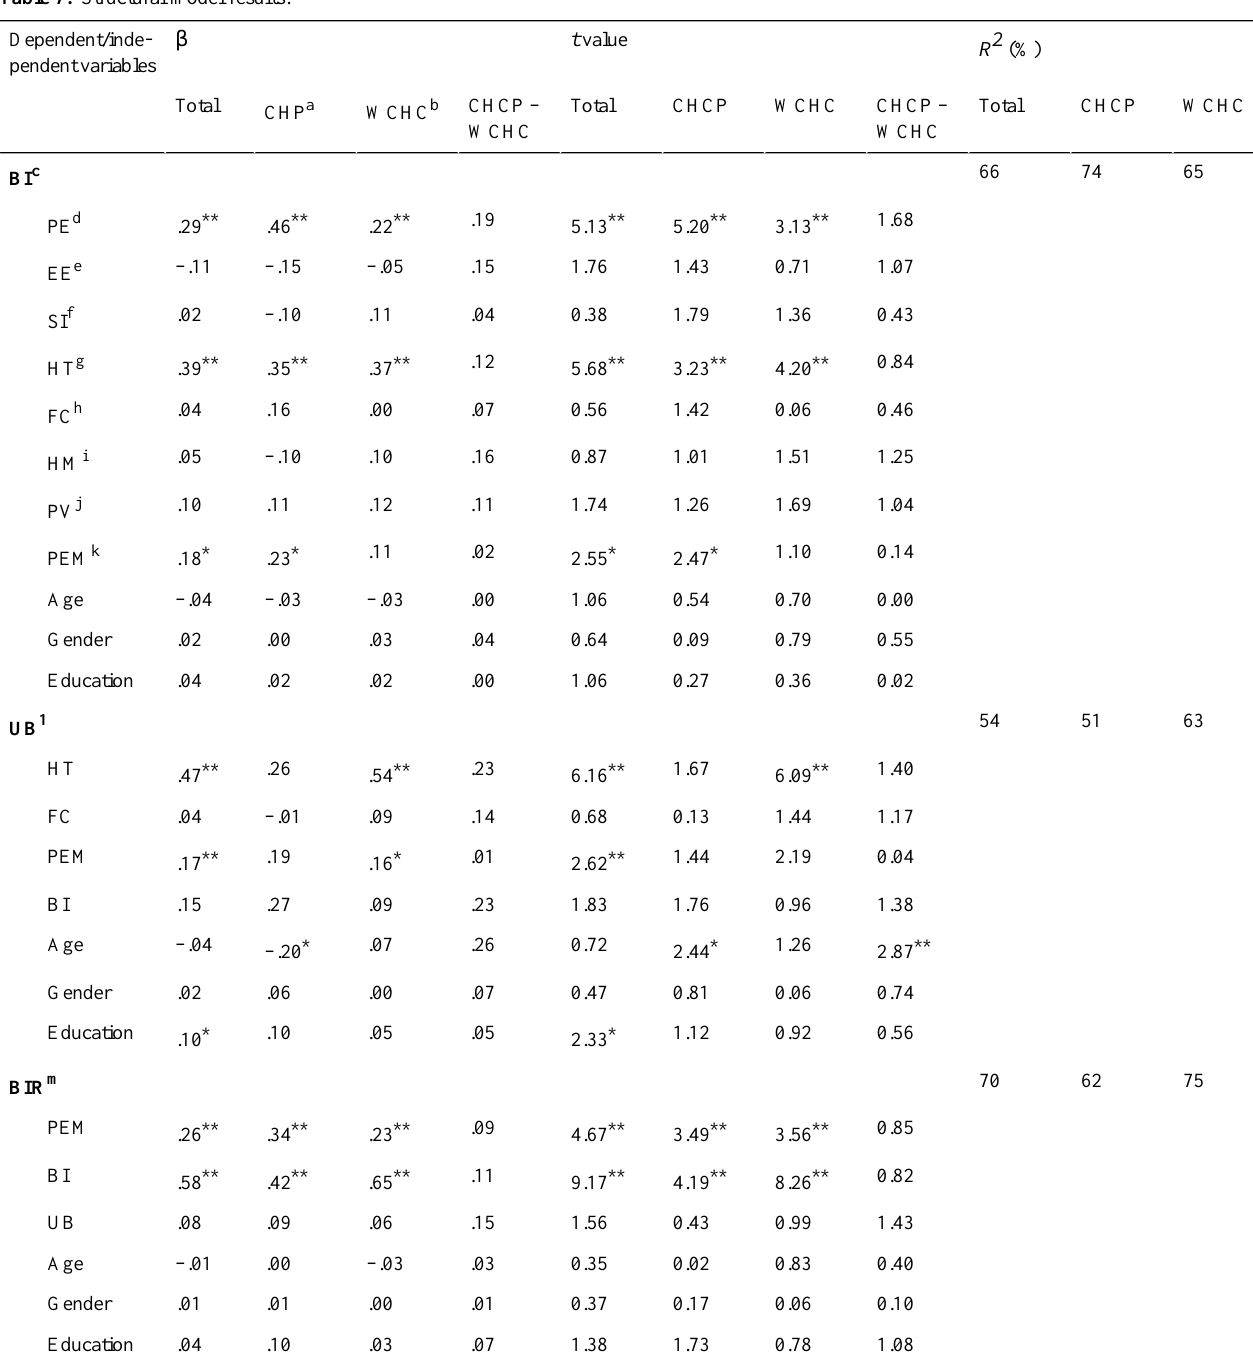
Table 7. Structural model